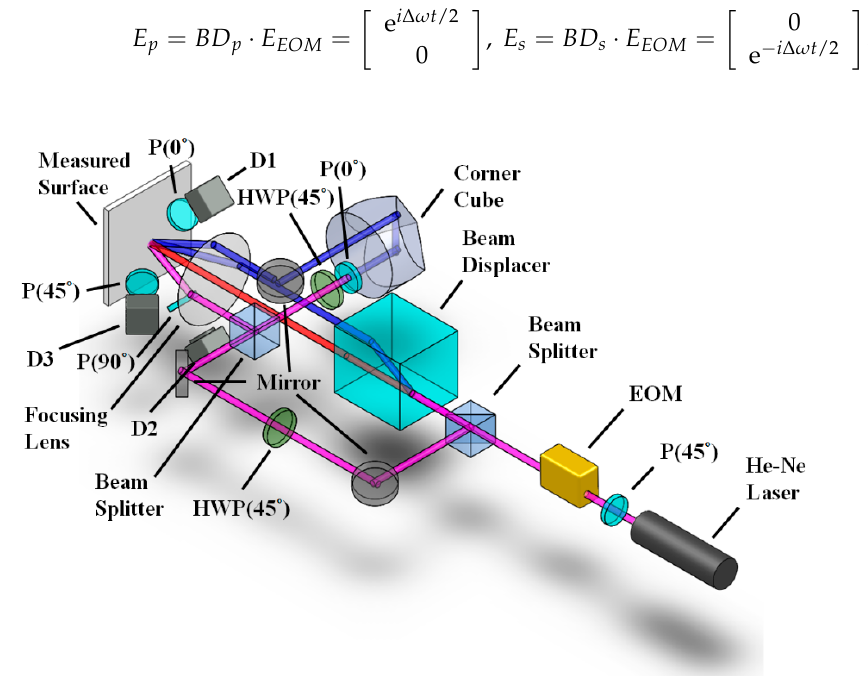
Figure 3. Diagram of the compound speckle interferometer configuration.